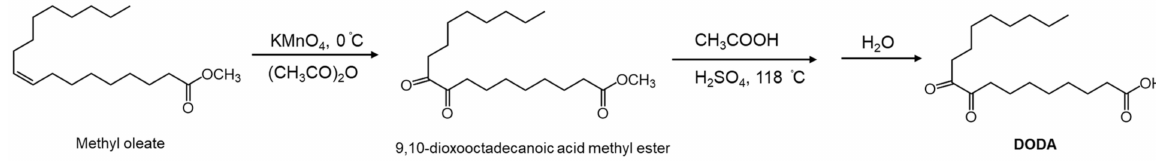
Figure 17. Synthesis of DODA [44]. Copyright John Wiley and Sons. Reproduced with permission.